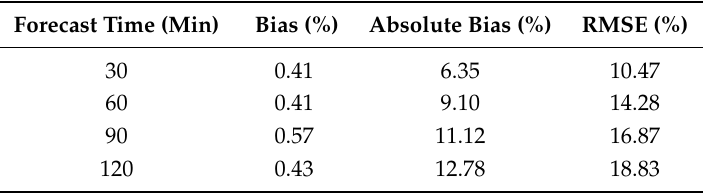
Table A2. Mean values of the bias, absolute bias and RMSE for all investigated cases. The basis for the calculation is the area of